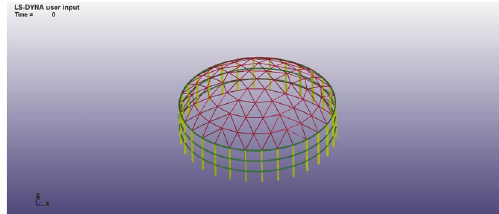
Figure 1: Layout of single-layer spherical shell structural